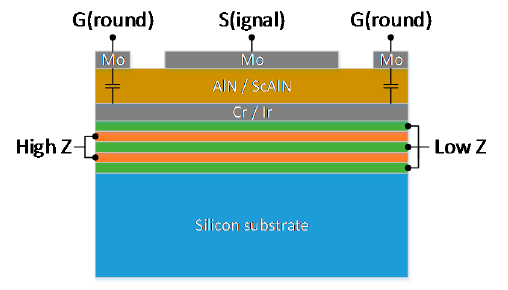
Figure 1. Schematic cross-sectional view on the SMR device investigated in this